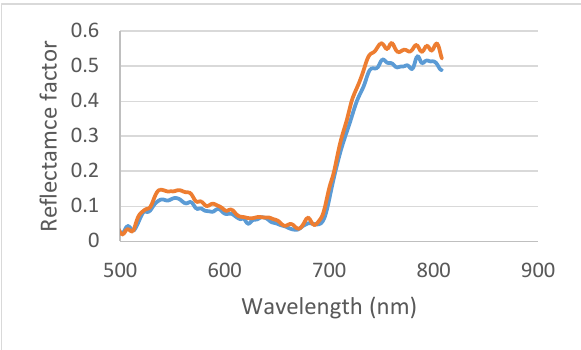
Figure 3. Two of the sampled ash trees.